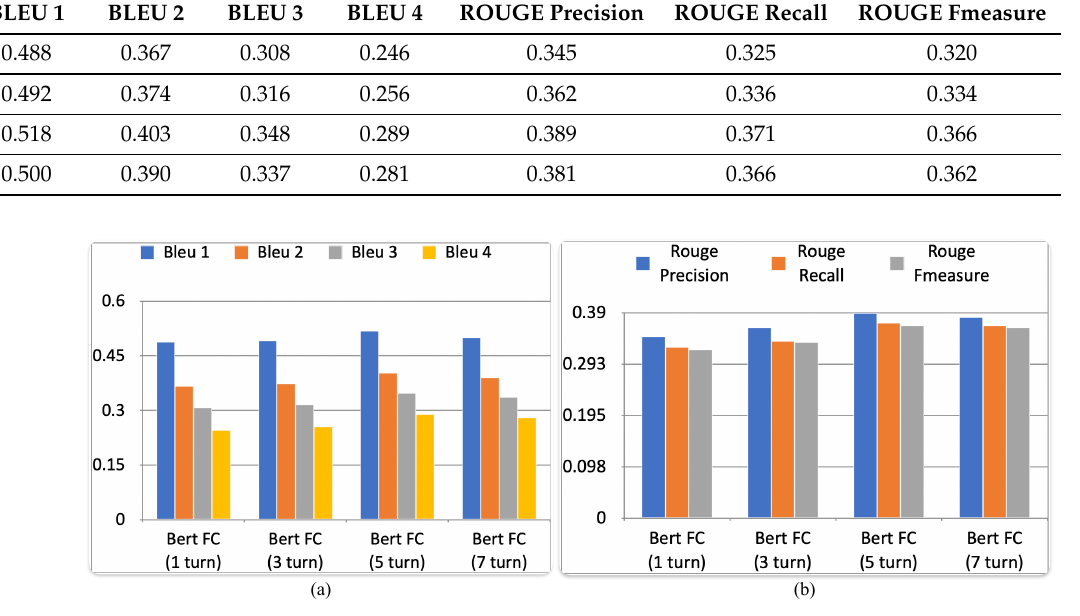
Figure 6. Chart showing the performance with different lengths of simulated conversation measured by BLEU score ( a ) and ROUGE score ( b